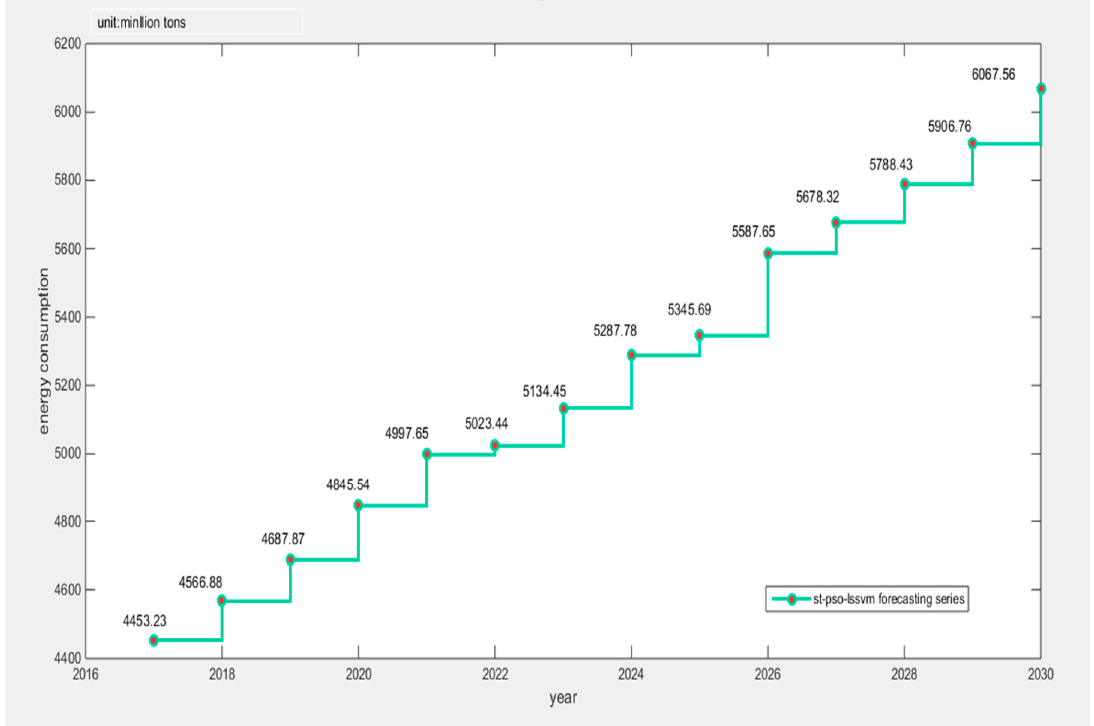
Figure 7. The forecasting results of energy consumption from 2017 to 2030 in China.